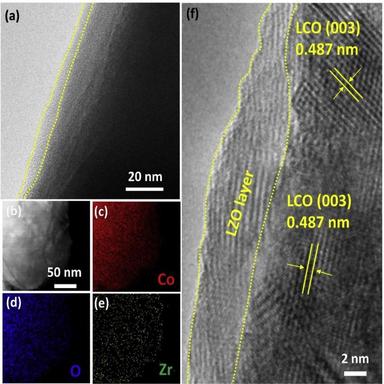
TEM characterizations of the 25 cycles of ALD-LZO deposited on the LCO particles (LZO@LCO). (a) a TEM image of the LZO@LCO composites; (b) a STEM image of the LZO@LCO composites; (c–e) EDX mapping of the Co, O, and Zr elements on the LZO@LCO composites; (f) a HRTEM image of LZO@LCO composites.